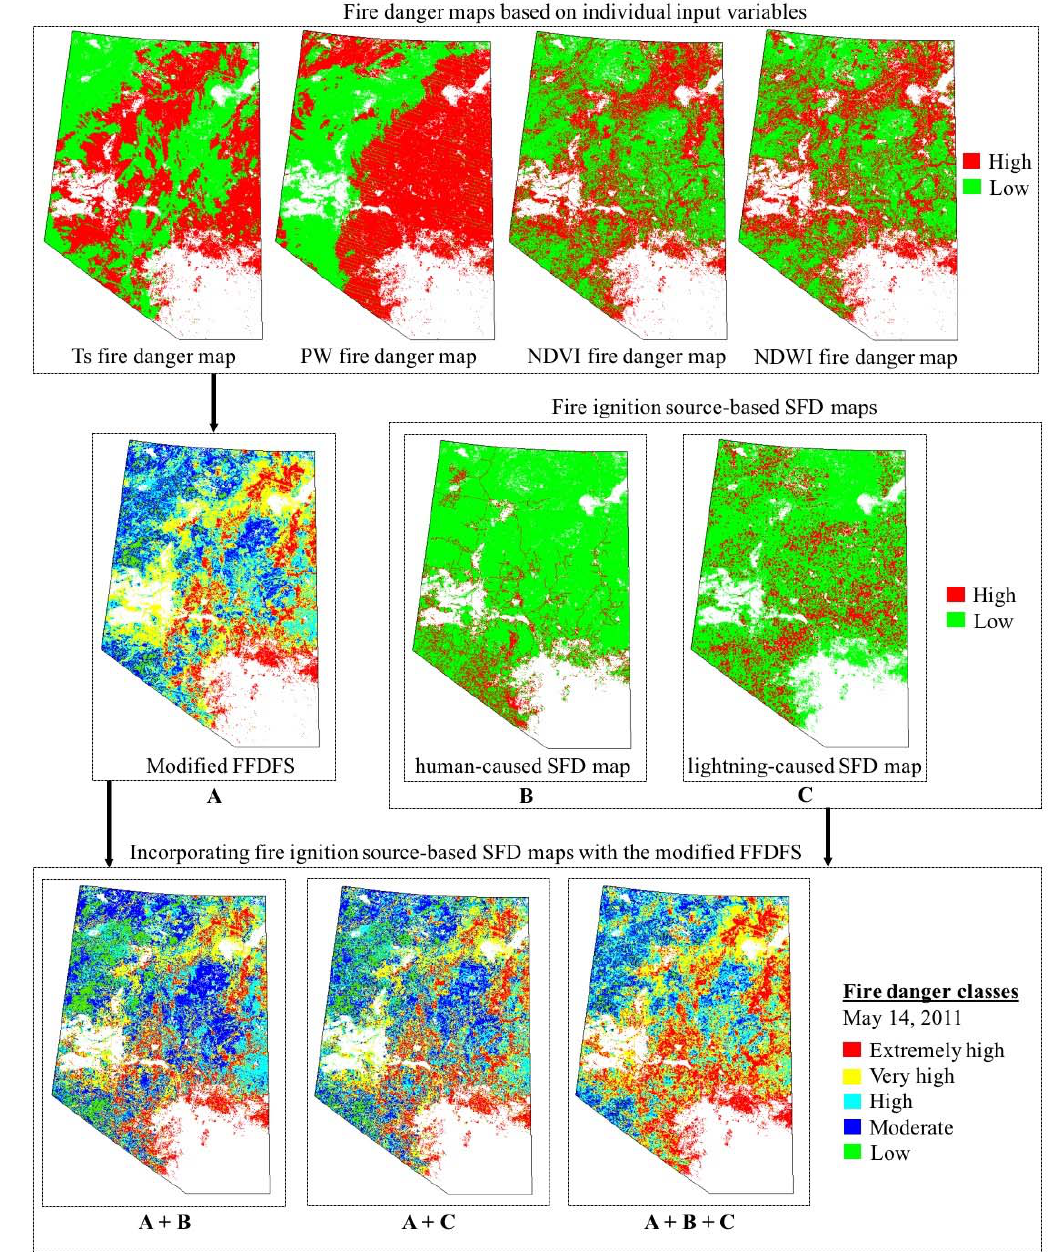
Figure 6. Example of fire danger maps produced on 14 May 2011 by the modified remote sensing-based FFDFS using the individual variable (Ts, PW, NDVI, and NDWI)-specific danger conditions; which was then integrated with the human- and lightning-caused SFD maps.